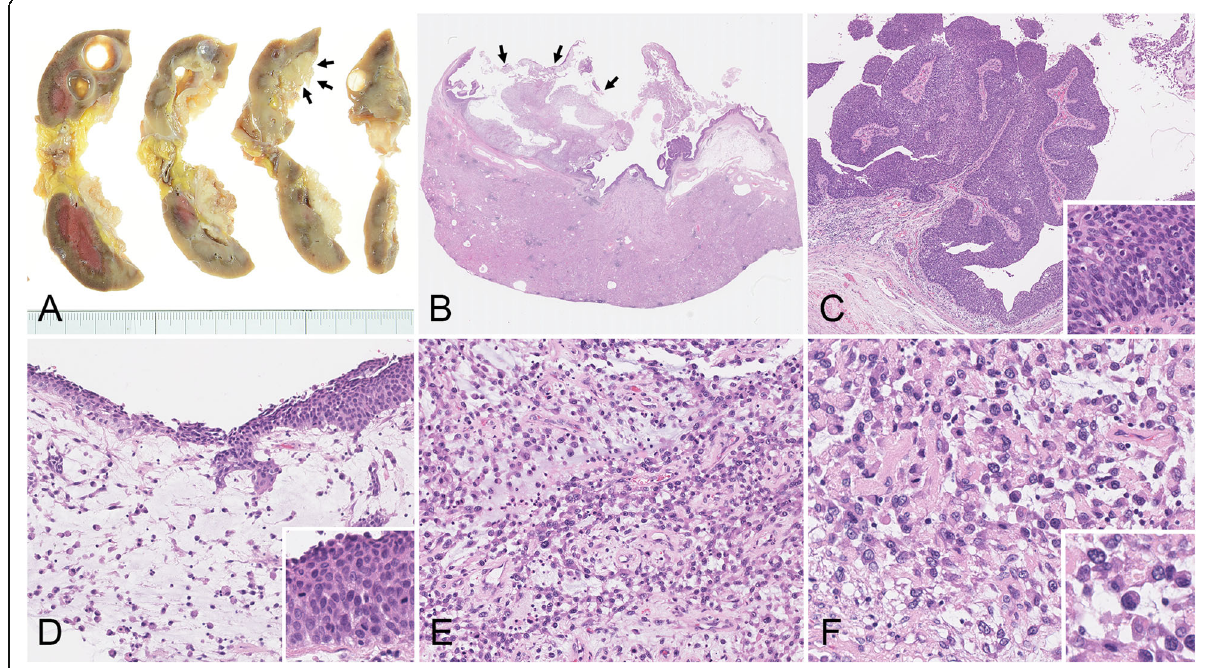
Fig. 1 Macroscopic and histological findings for a plasmacytoid urothelial carcinoma. a Gross examination of the cut surface of a nephrectomy specimen shows a whitish solid tumor with a partially myxoid change in the renal pelvis (arrows). b The tumor was mainly located in the renal pelvic mucosa and exhibited two distinct morphological components. c The tumor surface comprised a noninvasive urothelial carcinoma, including a high – grade papillary urothelial carcinoma and a carcinoma in situ. d Transitional findings between the urothelial carcinoma in situ and the invasive plasmacytoid urothelial carcinoma were recognized. e In the invasive area, the plasmacytoid tumor cells in the loose myxoid stroma were dyscohesive and lacked cell adhesions. f The plasmacytoid tumor cells had an eccentrically placed nucleus and an abundant amphophilic to eosinophilic cytoplasm. b - f . Hematoxylin and eosin – stained sections. Original magnification: b , Scanning view; c , ×40; d and e , ×200; f